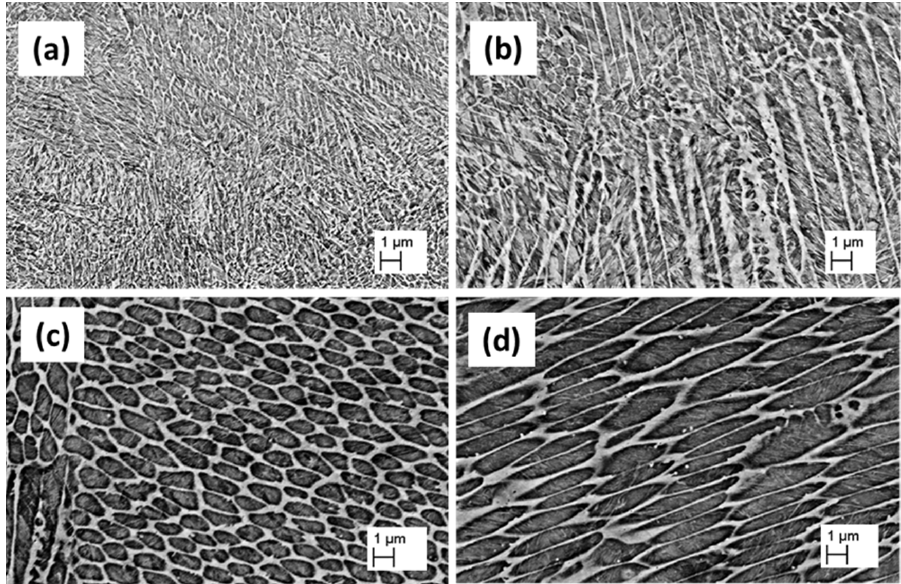
Figure 2. Standard 1.2343 SEM micrograph: ( a ) the as-built 30 µm layer thickness and ( b ) 60 µm layer thickness of 1.2343. Preheated at 500 °C SEM micrograph: ( c ) 30 µm layer thickness and ( d ) 60 µm layer thickness.